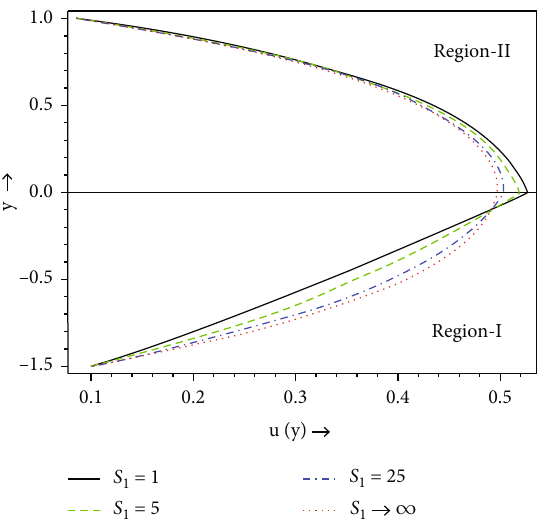
Figure 2: E ff ect of couple stress parameter S components.